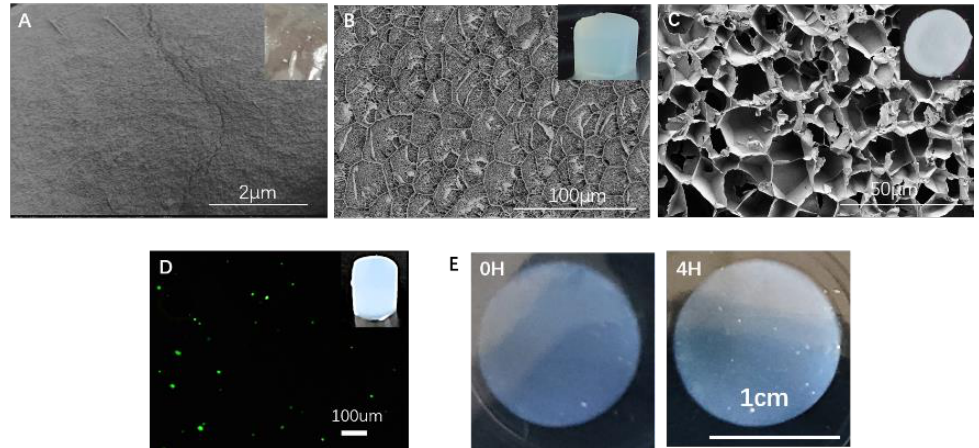
Figure 5. Scaffolds prepared from various silk solutions and gelatin solution. ( A ): SEM of membrane from 3% CSF, ( B ): Morphology of 1% CSF-SF hydrogel, ( C ): Morphology of 6% CSF-SF porous scaffold, ( D ): Cells in 1% CSF-SF hydrogel, ( E ): Morphology of 3% CSF-gelatin hydrogel immersed in PBS at a different time.